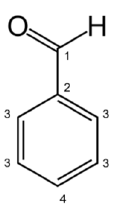
Figure 5. Differentiation of benzaldehyde carbon atoms detectable by T1 13 C NMR.